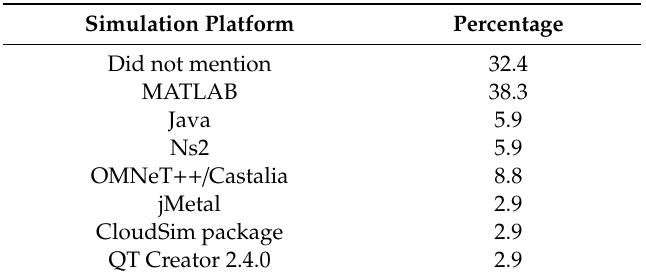
Table 6. Simulation platforms analysis.